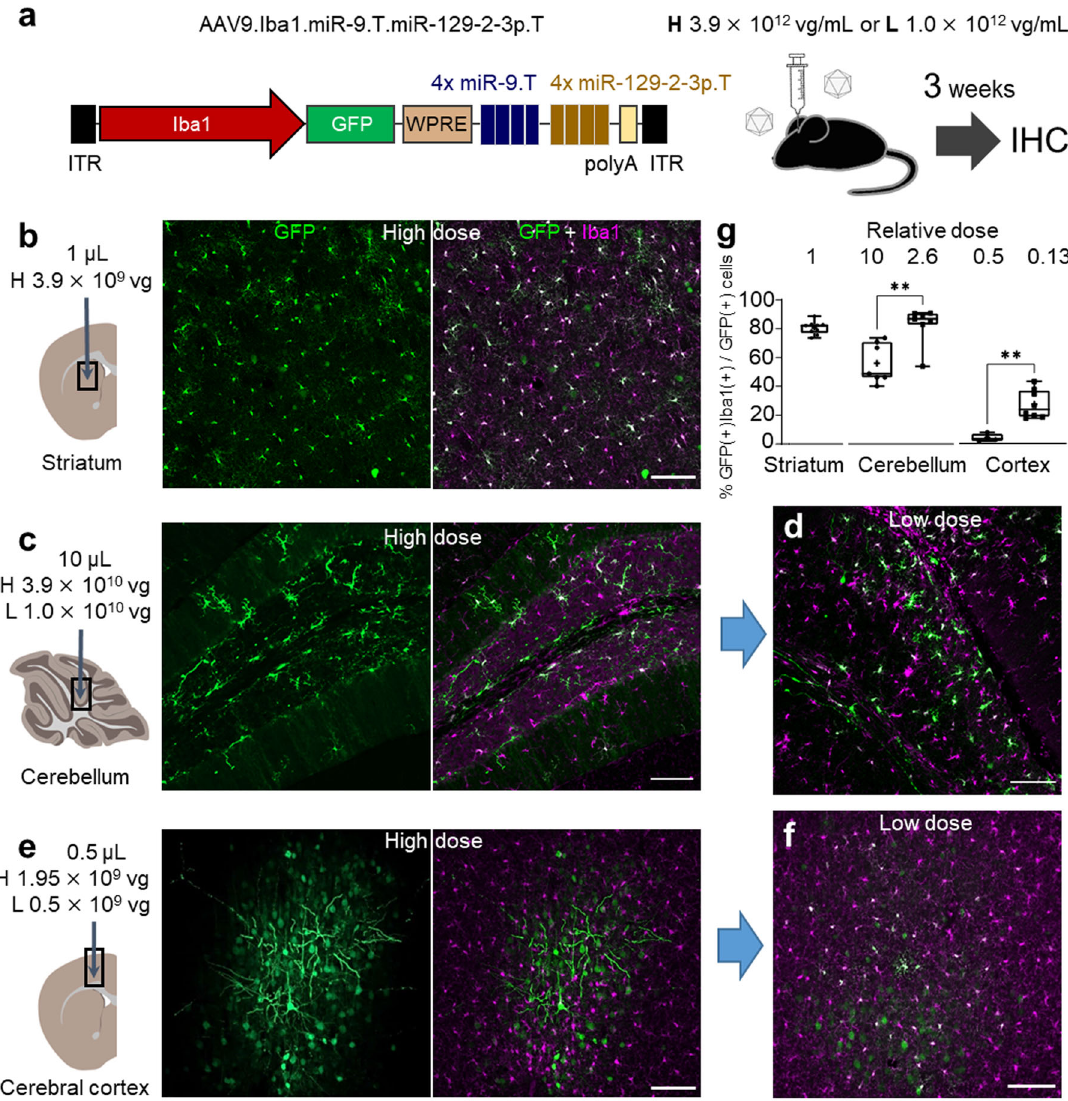
Fig. 3 Maintenance of microglia-speci fi c transduction by AAV injection at optimal doses. a AAV construct (AAV9.Iba1.miR-9.T.miR-129-2-3p.T) and schematic of the virus injection. Mice that received an injection of AAV in three brain regions at the same dose as Fig. 2 (High dose; H) or about one quarter (Low dose; L) were examined 3 weeks post-injection by immunohistochemistry. b – f Immunohistochemistry of the striatum ( b ), cerebellum ( c , d ), and cerebral cortex ( e , f ). Injected doses were described above the schemas. Note the strong and ef fi cient GFP expression in microglia with weak transduction of Iba1-negative non-microglial cells in the striatum and cerebellum ( b , c ). In contrast, the cerebral cortex showed GFP expression mostly in non-microglial cells including those displaying pyramidal neuron-like morphology ( e ). Lowering the viral dose to a quarter suppressed GFP expression in non-microglial cells in the cerebellum and cerebral cortex ( d , f ). Scale bars; 100 μ m. g Summary graph showing the cell speci fi city for microglia in the three brain regions. Numbers above the graph represent relative doses of injected AAV when the dose injected to the striatum is taken as 1. Box-and-whisker plots display the median (centerline), 25th to 75th percentile (box), and minimum to maximum values (whiskers) (striatum, n = 9 mice per group; cerebellum, n = 7 mice per group, two-tailed unpaired t -test, t (12) = 3.711, ** P ≤ 0.01 for high dose vs. low dose; cerebral cortex, n = 4 mice per group, two- tailed unpaired t -test, t (6) = 4.513, ** P ≤ 0.01 for high dose vs. low